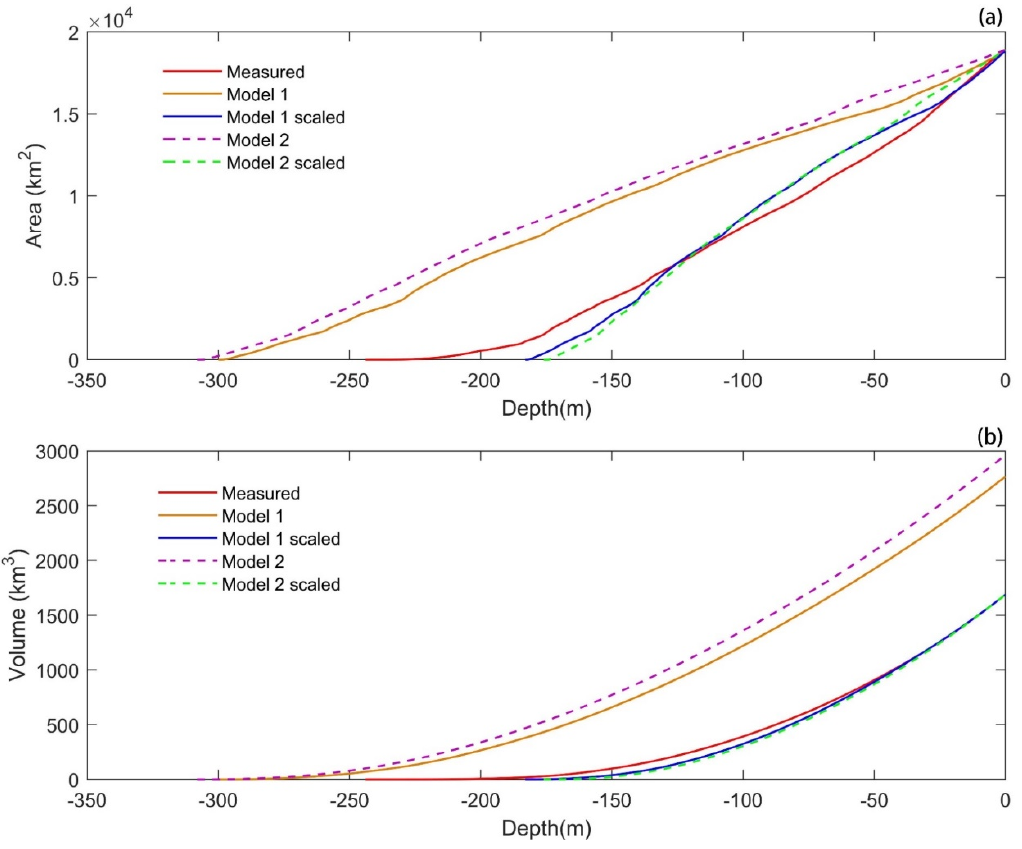
Figure 7. The ( a ) area-depth curve and ( b ) volume-depth curve of Lake Ontario in model 1 and model 2.